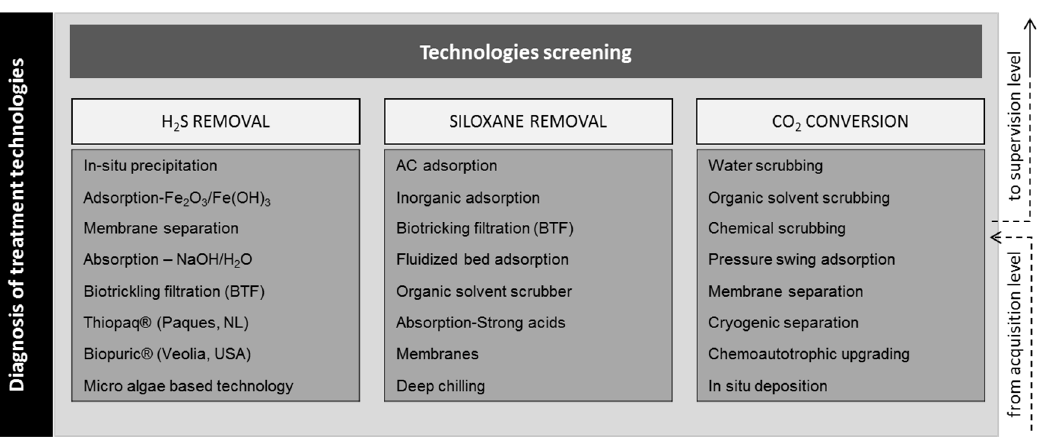
Figure 2. Scheme diagram of the diagnosis level.